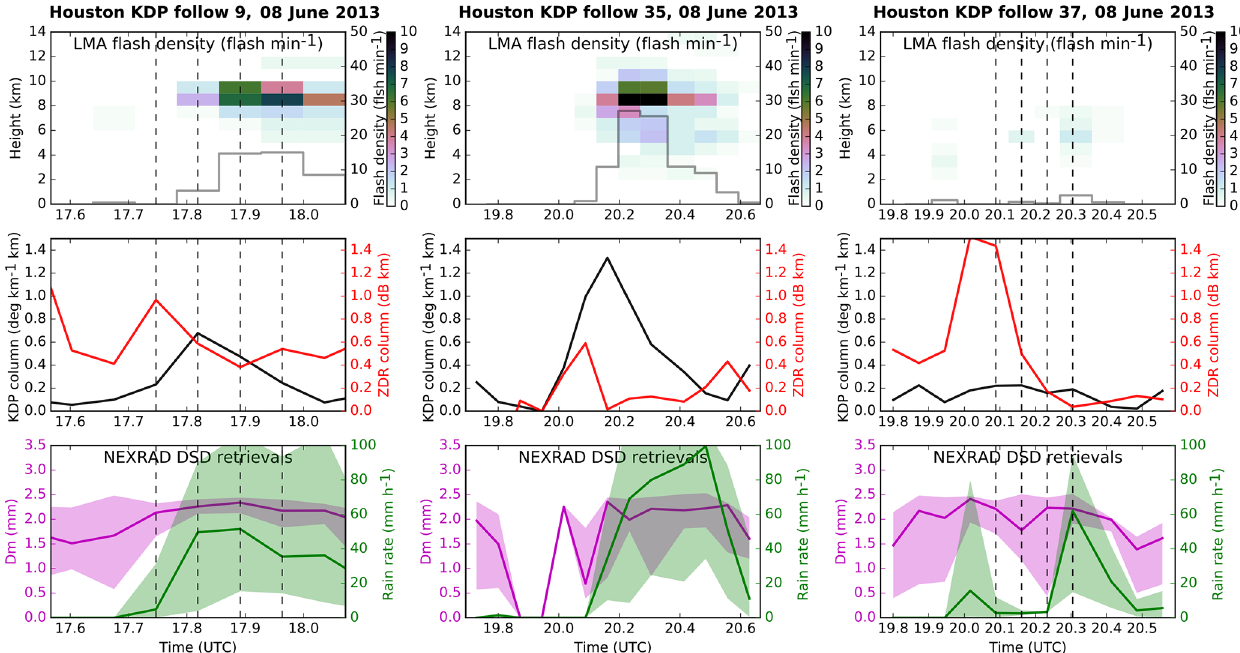
Figure 4. Time series from three K DP column objects tracked from observations show (top-to-bottom) lightning flashes per KHGX volume time (grey line) and occurrence density as a function of height (see color bar), K DP and Z DR column strength (calculated following Eq. 1), and retrieved rain rate and drop D m . Lightning and rain statistics collected within 2.5km of the tracked K DP column center. Vertical dashed lines indicate times of column 9 and 37 cross sections shown in Figs. 5 and